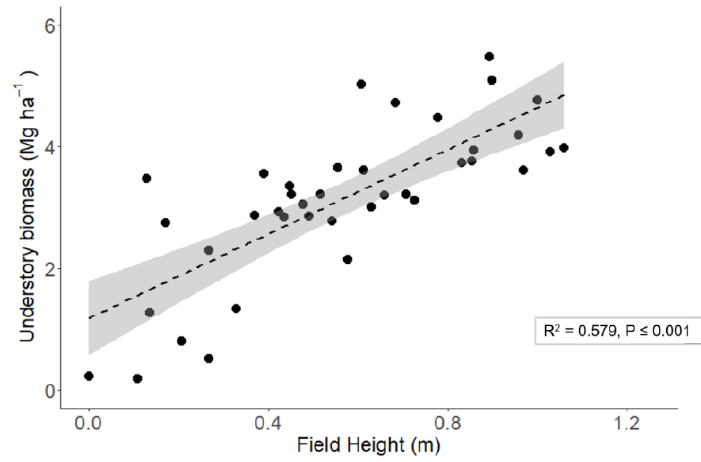
Figure 5. Relationship between field height (m) and understory biomass (Mg ha −1 ) along with the confidence interval of the regression line.